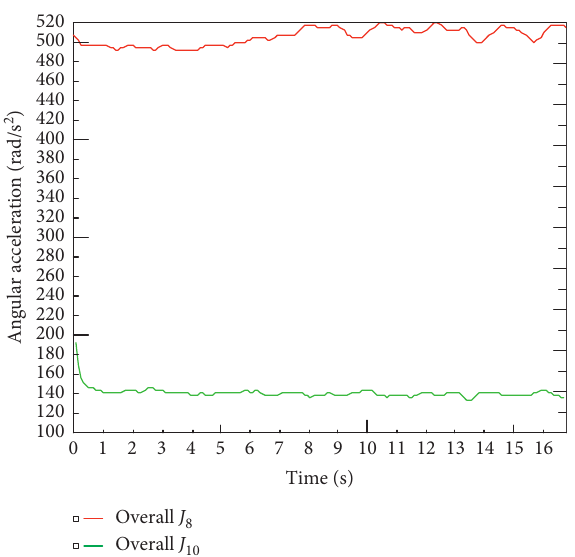
Figure 30: The overall angular acceleration curves of the primary flywheel and the input shaft of the gearbox matching the DMF with the bifilar CPVA under the idling